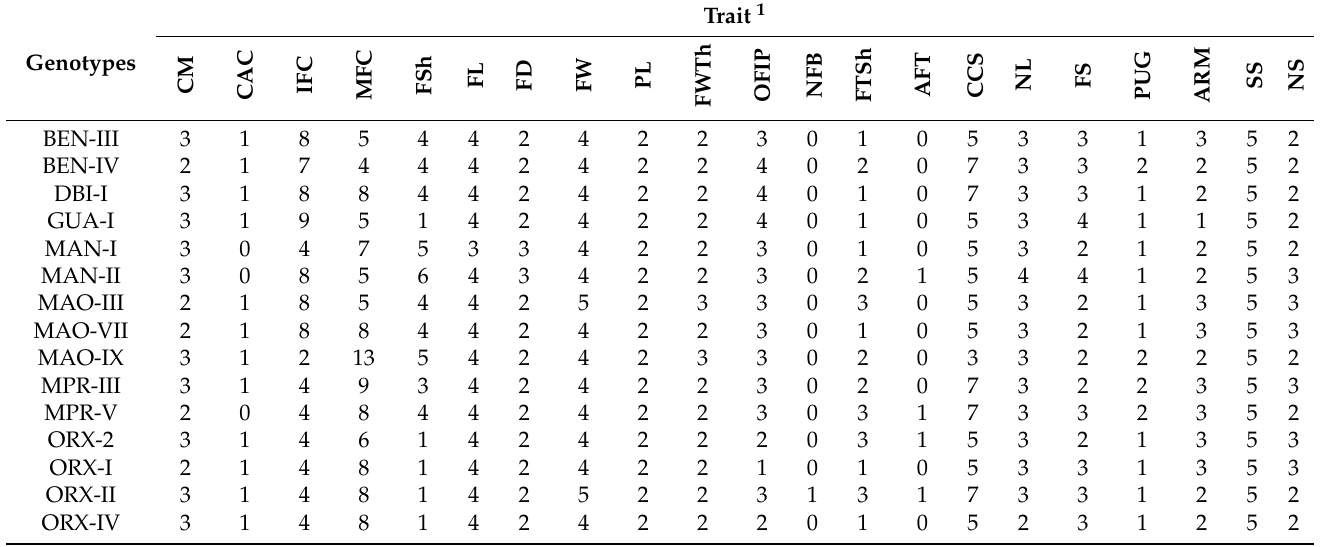
Table 1. Values of 21 morphological descriptors evaluated in 23 genotypes of Capasicum chinense Jacq. from shops and markets in Amazonas, Par á and Rond ô